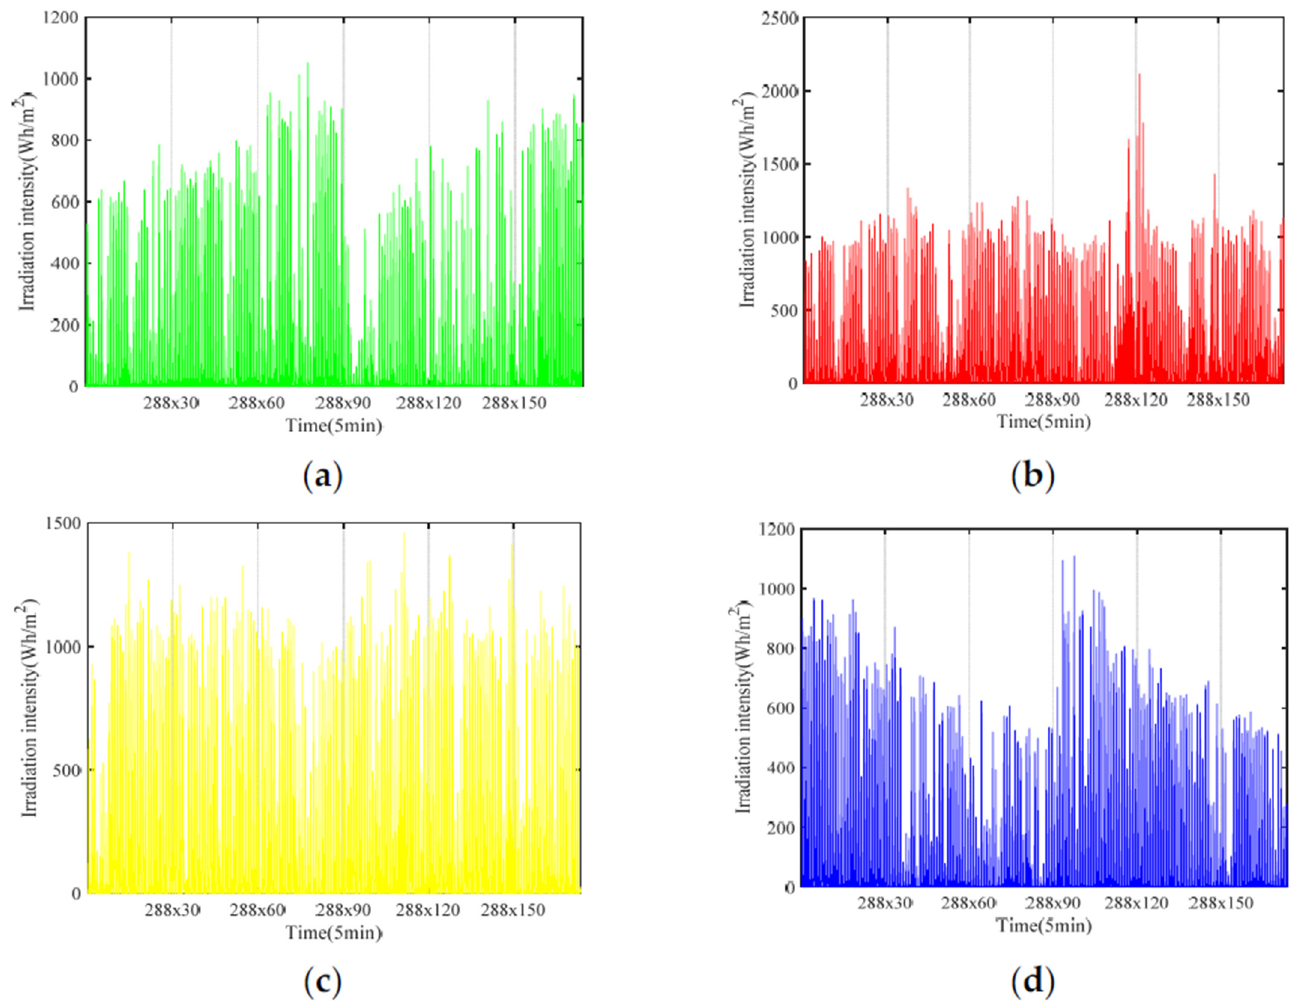
Figure 3. Solar radiation in four seasons in 2018 and 2019. ( a ) Spring; ( b ) Summer; ( c ) Autumn; ( d ) Winter.